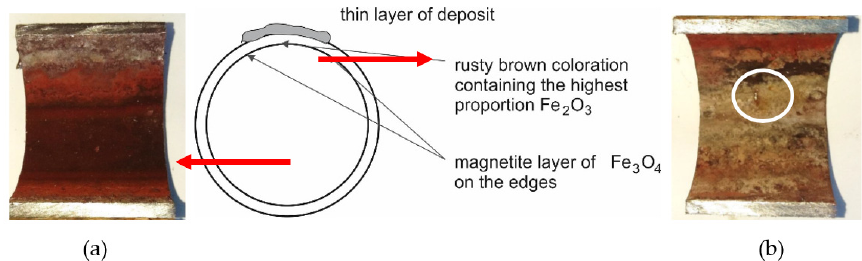
Figure 7. The inner surface of cutout 3 with the deposit: ( a ) the lower part of the tube; ( b ) the upper part of the tube placed under the deposited layer according to Figure 6a.